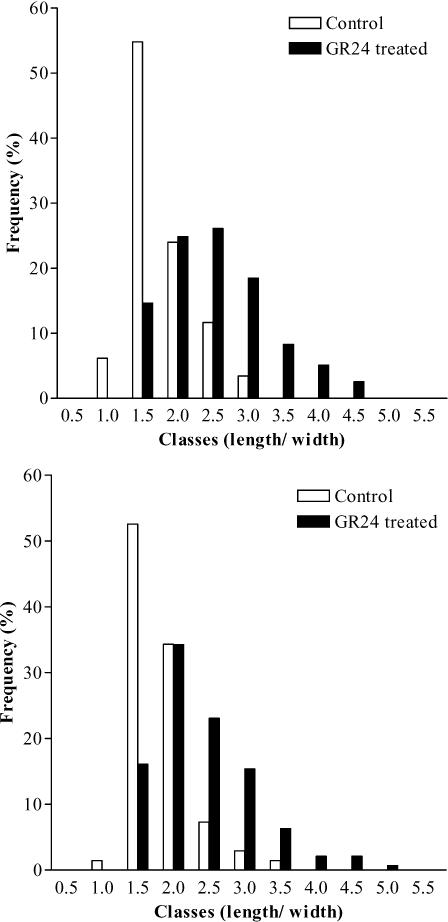
Effect of GR24 on Size of Mitochondria in Hyphae of
Gi. rosea Stained with Mitotracker Green
Hyphae were treated with 30 nM GR24 or with 0.001% acetone for 1 h (A) or 5 h (B). Results are expressed in frequency (%) distribution of length/width ratios (
n = 140–150 mitochondria).